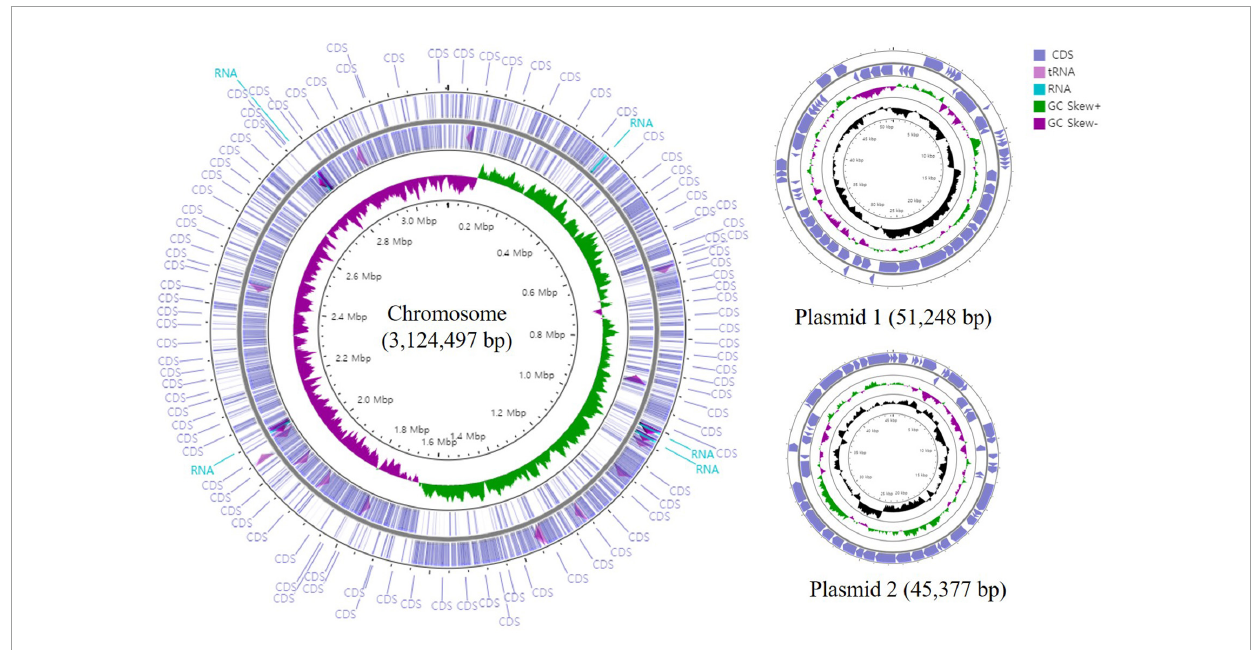
FIGURE1 Circular genome map of L. paracasei ATG-E1.